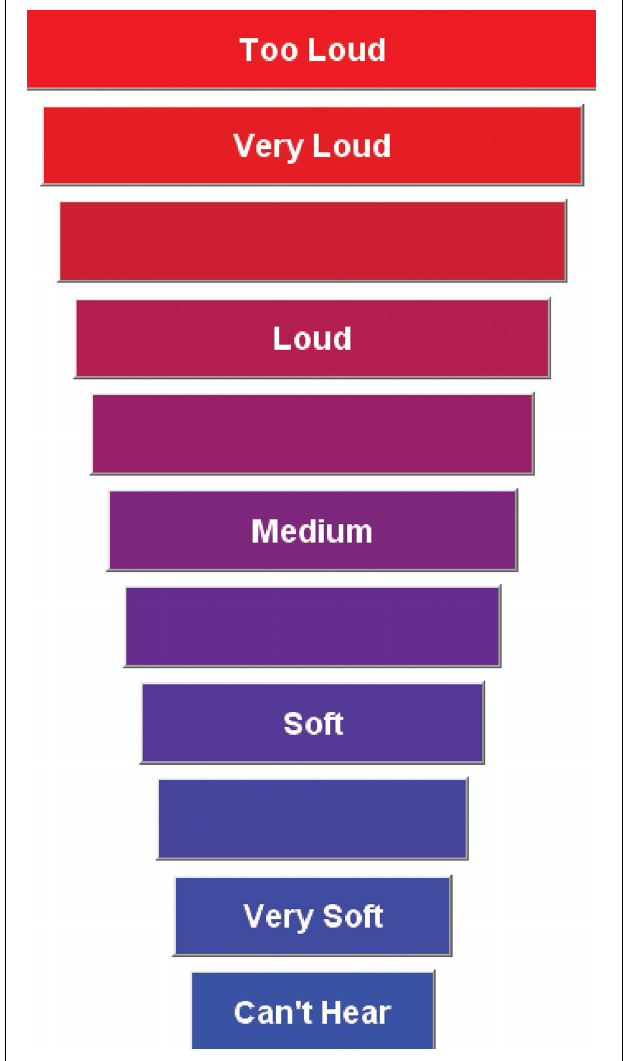
FIGURE 2 | Display of the categorical loudness scale with 11 response categories. This is displayed on a computer monitor used by participants to rate the loudness of the signal. The horizontal bars increase in width from the softest level to the loudest level. This figure appeared previously in Rasetshwane et al.